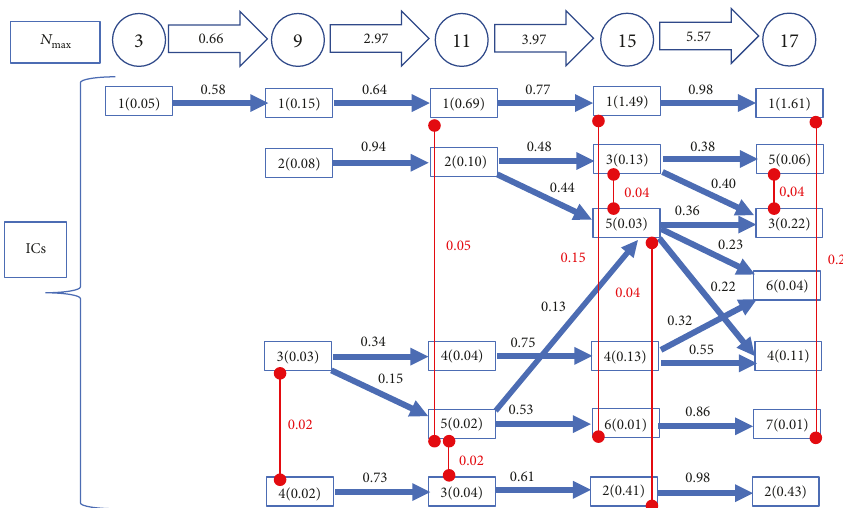
= 3, 9, 11, 15, 17 (circles) with max